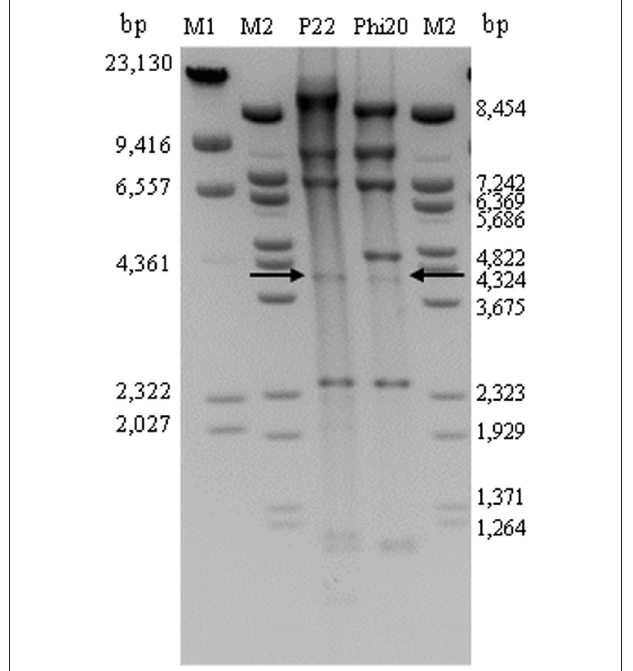
FIGURE 5 | Determination of genome ends of UAB_Phi20 phage after digestion with EcoRI enzyme. Genome of bacteriophage P22 digested with Eco RI was used as control. Arrows indicate the 4007-bp fragment containing the pac sequence. Lambda DNA digested with Hin dIII (M1) or Bst EII (M2) were used as molecular markers. Sizes (bp) are indicated on both sides of the